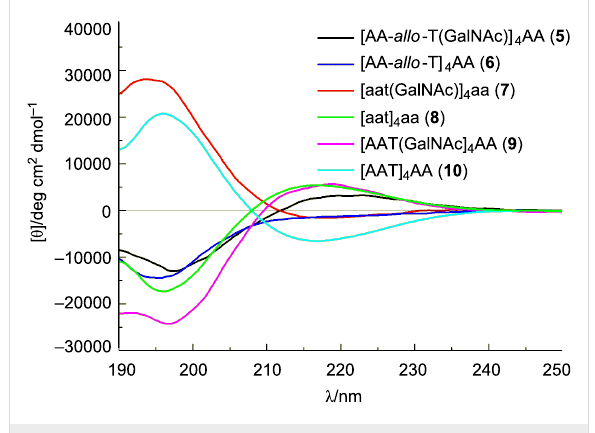
Figure 1: CD spectra of the monosaccharide-substituted AFGP analogues ( 5 and 7 ) and their corresponding aglycons ( 6 and 8 ) measured at a concentration of 0.2 mg mL − 1 in water at 20 °C. For comparison, the spectra of monosaccharide-substituted glycopeptide with naturally occurring sequence 9 and its correlate aglycon 10 are shown [16]. Capital letters symbolize L-amino acids (A = L-Ala, T = L-Thr), lowercase letters D-amino acids (a = D-Ala, t = D-Thr).